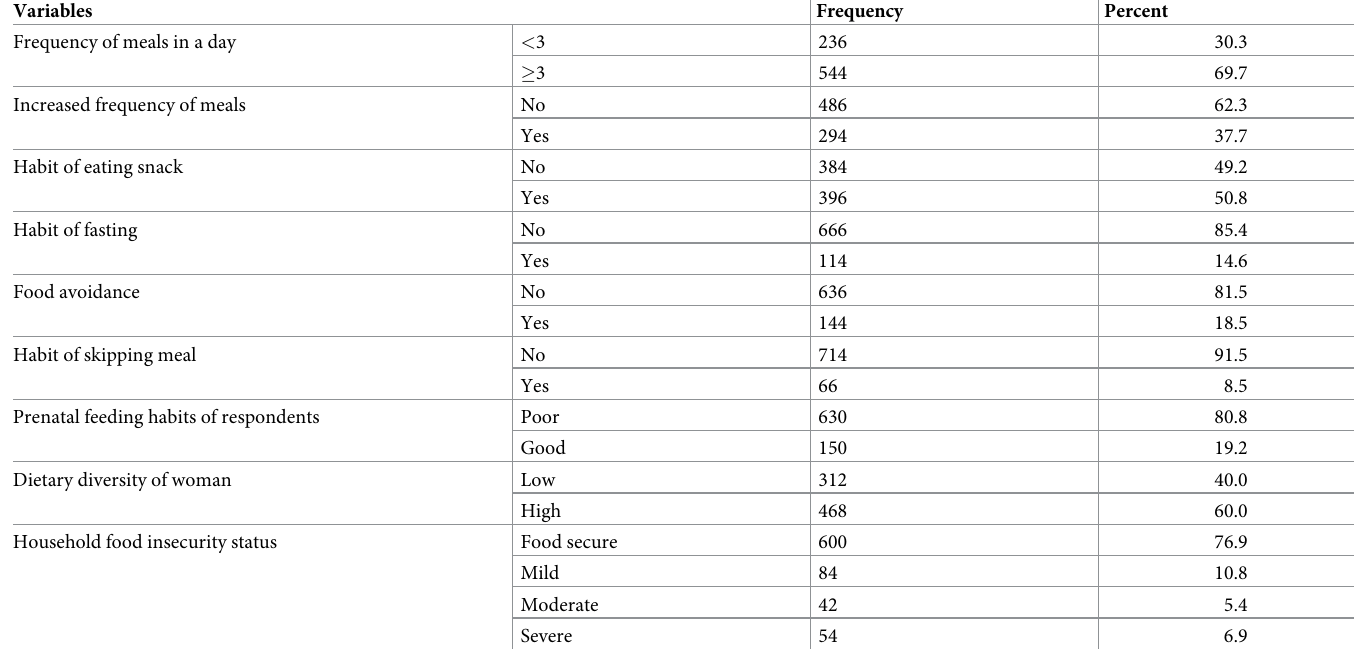
Table 3. Prenatal feeding habits of participants attending antenatal care services at public hospitals of West Wollega Zone, 2020. Variables Frequency of meals in a day